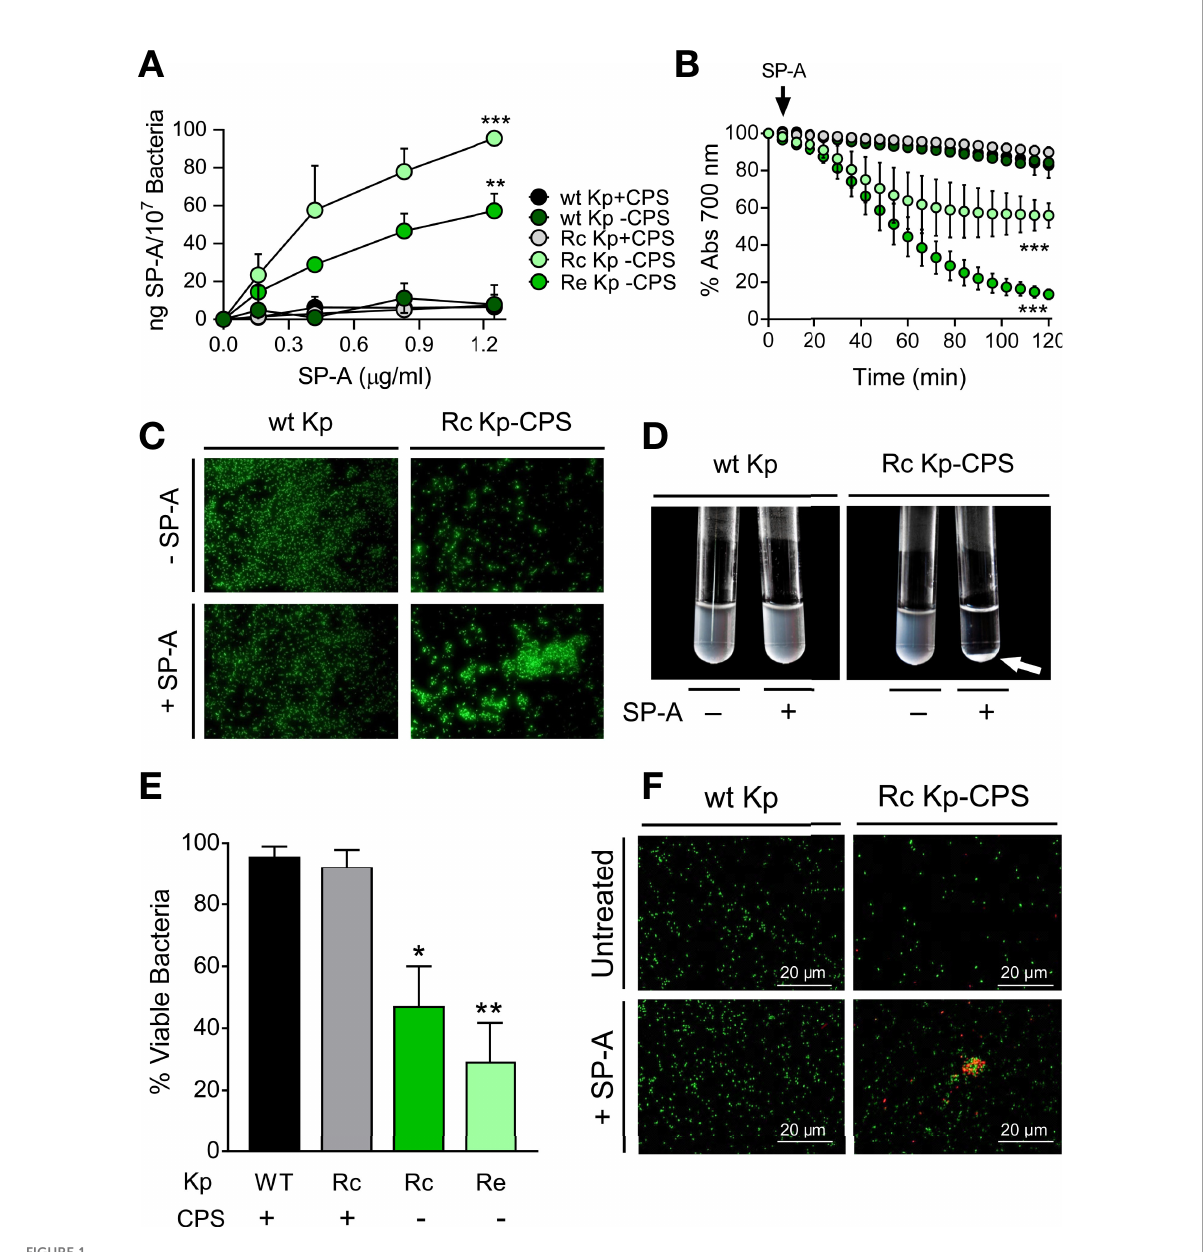
FIGURE 1 SP-A binds, aggregates, and kills deep rough non-capsulated K pneumoniae , but not strains expressing long-chain LPS and/or capsule. (A) K pneumoniae strains (10 7 CFU) were incubated with biotinylated SP-A (0 to 1.25 µg/ml), and total Klebsiella -associated SP-A was measured by solid-phase binding and expressed as total ng of SP-A/10 7 bacteria. Data are means ± SD of three independent experiments. A value of *** p < 0.001 was obtained for the one-way ANOVA, followed by the general multiple-comparison Bonferroni test. (B) Bacterial aggregation by SP-A (25 m g/ml) was determined by monitoring the changes in absorbance at 700 nm during 2 h at 37°C without shaking. Absorbance of strains incubated in the absence of SP-A corresponds to 100%. Data are means ± SD (n=3, each in triplicate). (C) SP-A-induced bacterial aggregation was visualized by fl uorescence microscopy using wt and Rc-CPS K pneumoniae strains expressing GFP. Images shown are representative of three independent experiments with similar results. Scale bar, 20 m m. (D) SP-A-induced bacterial aggregation of the Rc-CPS strain but not of the wt strain was also visualized by the formation of bacterial pellets (white arrow) after 2 h of incubation with 25 m g/ml SP-A. (E) The antimicrobial activity of SP-A on K pneumoniae strains was determined by incubation of bacteria (10 5 CFUs/ml) in the absence or presence of SP-A (100 µg/ml) for 1 h at 37°C. Then, bacteria were plated on LB agar for CFU count after 18 h of incubation at 37°C. The results are shown as % viable bacteria (percentage of live colony counts compared with untreated control). Data are means ± SD of three independent experiments with three biological replicates. (F) Bacterial killing was also visualized by fl uorescence microscopy. Strains expressing GTP (wt Kp and Rc Kp-CPS) were incubated with or without 100 µg/ml SP-A and stained with propidium iodide to assess viability. Images shown are representative of three independent experiments. Scale bar, 20 m m. In (A) , (B) , and (E) , results were statistically analyzed by one-way ANOVA followed by the Bonferroni multiple-comparison test. * p < 0.05, ** p < 0.01, and *** p < 0.001 when comparing SP-A-treated with untreated K pneumoniae